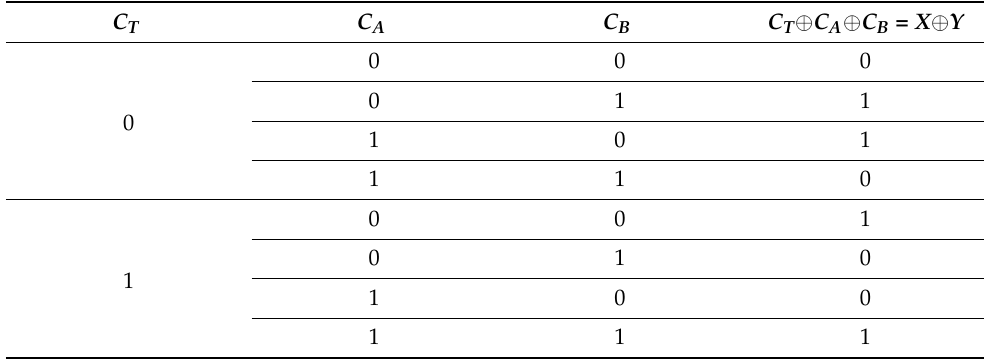
Table 1. Corresponding table of information